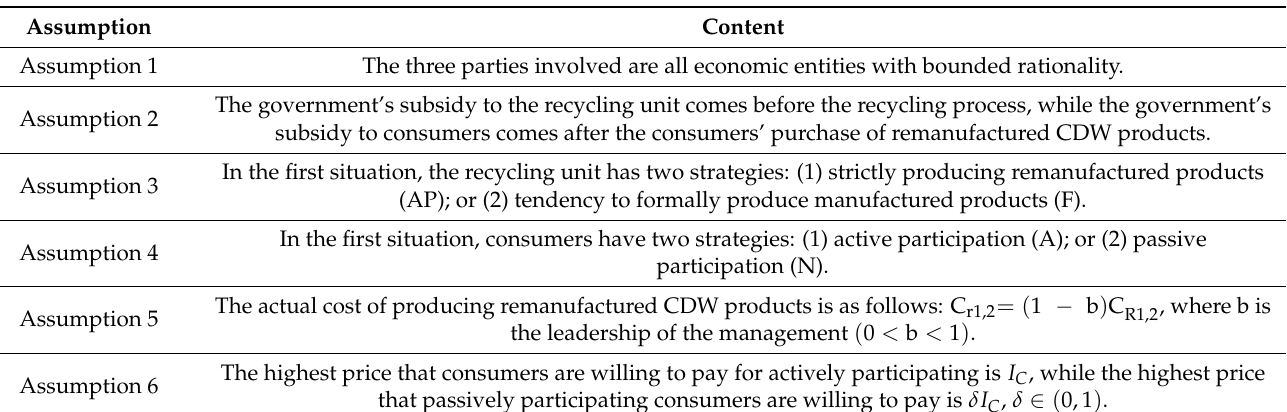
Table 1. The summary of the assumptions in the evolutionary